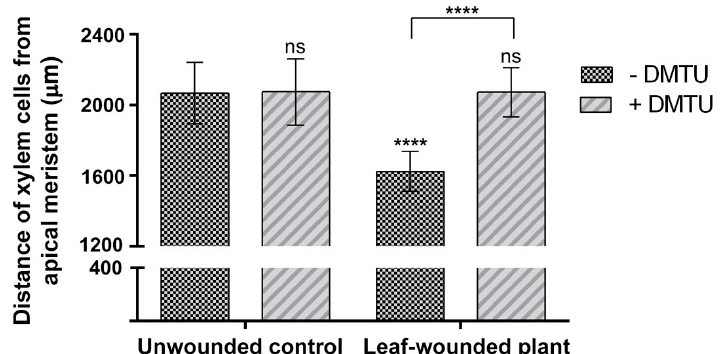
Figure 2. Analysis of differences in protoxylem maturation in leaf-wounded seedlings grown in medium with or without the H 2 O 2 -scavenger DMTU. Distances from the apical meristem of the protoxylem position (defined by the position of the first protoxylem cell with fully developed secondary cell wall thickenings) are reported. These experiments were repeated at least five times with ten seedlings analysed each time (mean values ± SD; n = 50). The statistical significance levels between unwounded control DMTU-untreated plants and DMTU-treated and/or wounded plants were evaluated by p levels as follows: ****, p ≤ 0.0001; ns, not significant. The significance levels between wounded DMTU-untreated and DMTU-treated plants are reported above the horizontal square bracket.